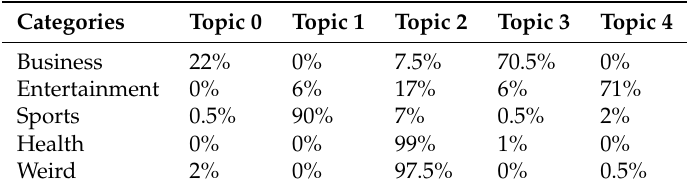
Table 5. Performance of K-means in labeling documents using Topic.